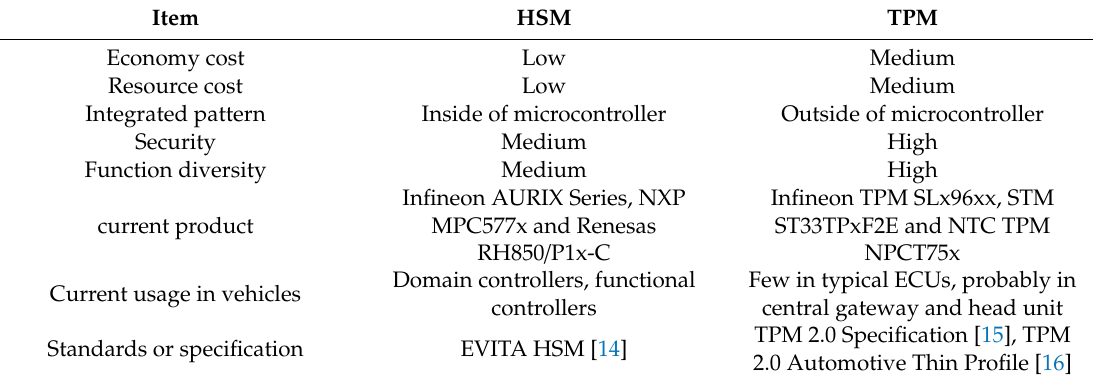
Table 6. Comparison for hardware security module (HSM) and trusted platform module